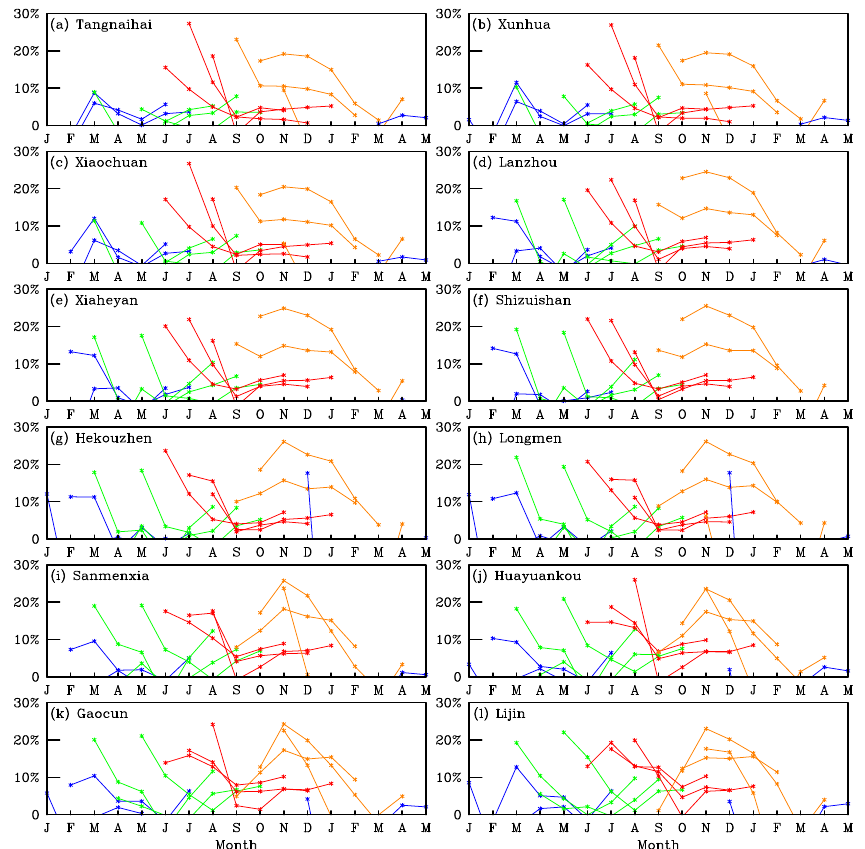
Figure 8. The root mean square error skill score (SS RMSE ) for streamflow as a function of start month and lead time at 12 hydrological gauges. The SS RMSE is defined as 1 − RMSE NMME /RMSE ESP , where RMSE NMME and RMSE ESP are the RMSEs for the streamflow forecasts from NMME/VIC and ESP/VIC verified against the offline-simulated